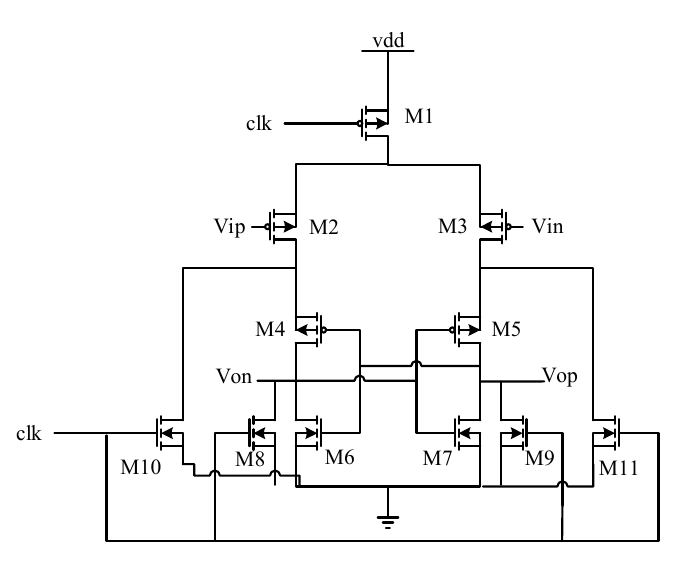
Figure 5. SAR comparator structure.